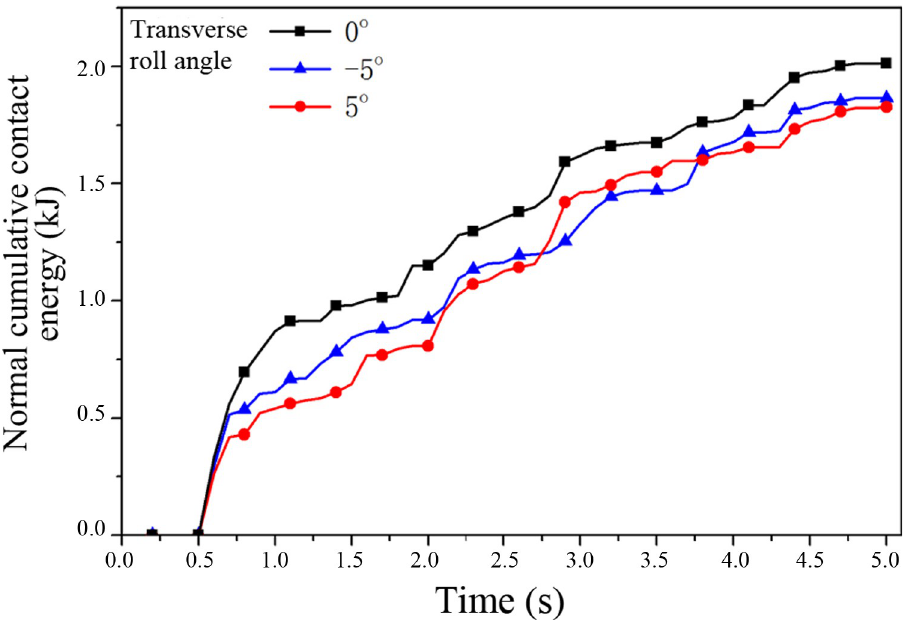
Fig 7. Normal cumulative contact energy curve of the middle trough under the different transverse roll